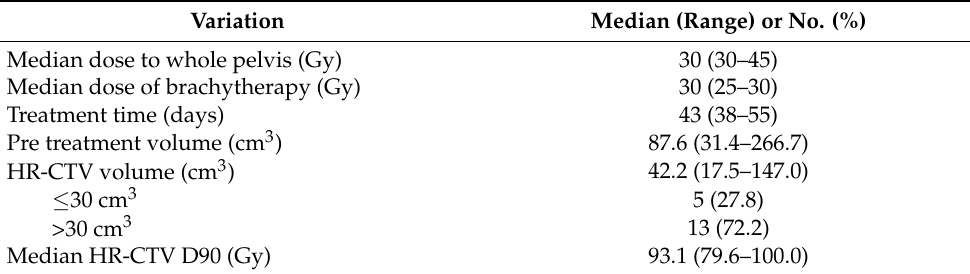
Table 2. Treatment details ( n =